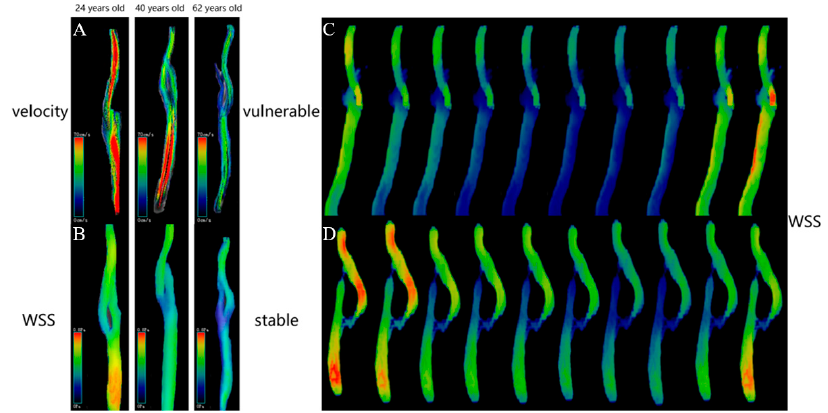
Figure 3. Examples of hemodynamic parameters (velocity and WSS) are visibly shown by 4D flow. ( A , B ): these cases showed that the velocity and WSS decreased with age in healthy volunteers’ carotids, and the proximal internal carotid artery decreased significantly [48]. ( C , D ): the WSS in the vulnerable carotid plaque increased and the stable carotid plaque declined, and the degree of changes varied at different time points